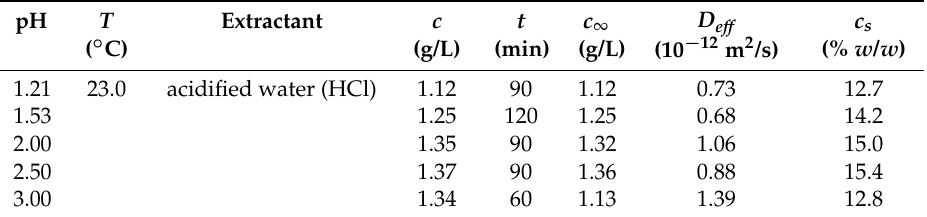
Table 2. Release data at different pH values.